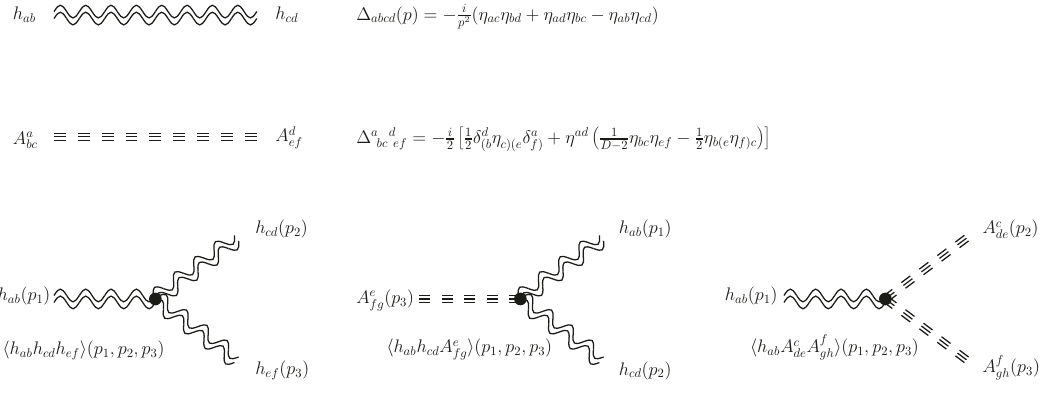
Figure 1 . Summary of Feynman propagators and vertices for the cubic gravity action in eq. (2.24).